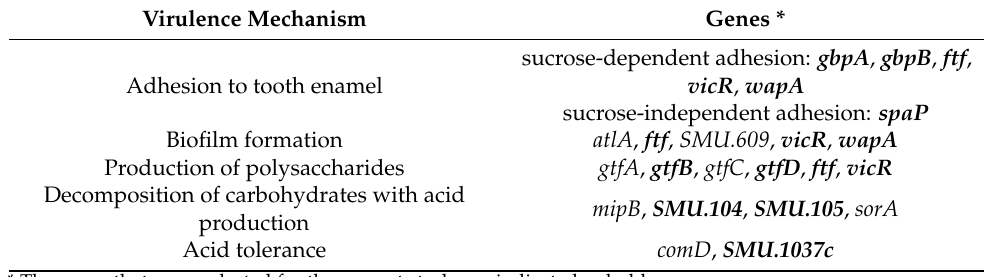
Table 2. Virulence mechanisms and their genes in mutans streptococci (adapted from [26]). Virulence Mechanism Genes * sucrose-dependent adhesion: gbpA , gbpB , ftf , vicR , wapA Adhesion to tooth enamel sucrose-independent adhesion: spaP Biofilm formation atlA , ftf , SMU.609 , vicR , wapA Production of polysaccharides gtfA , gtfB , gtfC , gtfD , ftf , vicR Decomposition of carbohydrates with acid mipB , SMU.104 , SMU.105 , sorA production Acid tolerance comD ,